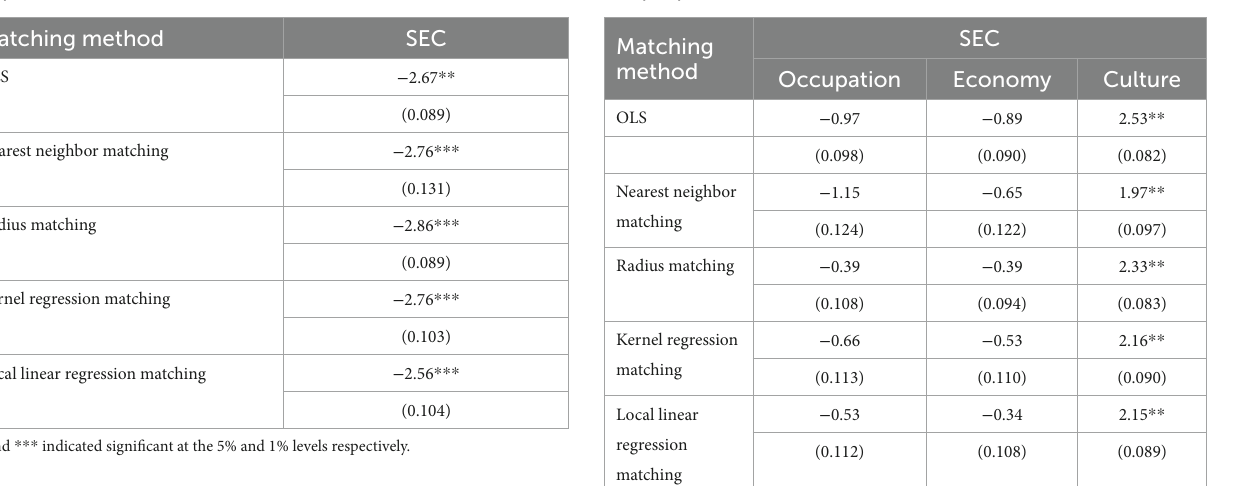
TABLE 6 Processing effect of left-behind duration on children’s SEC (ATT).